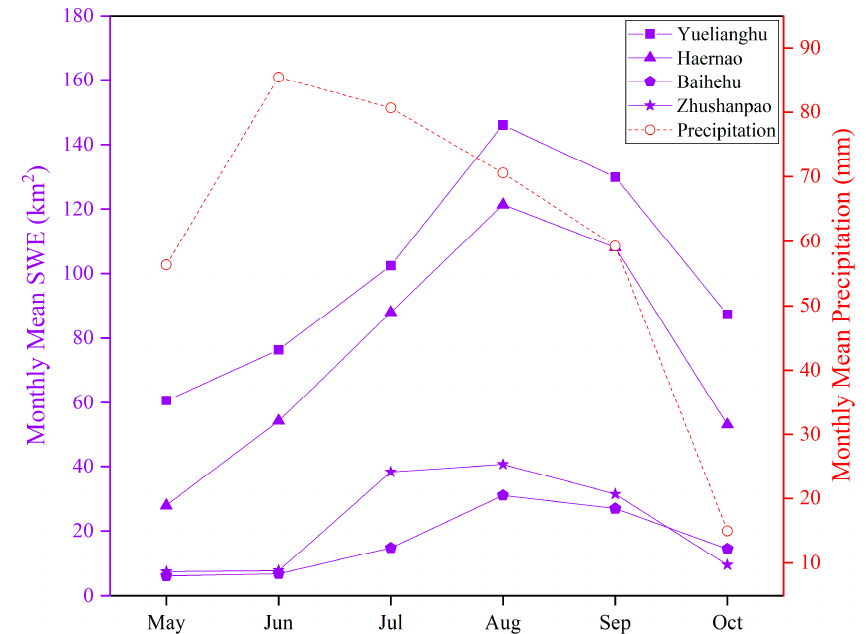
Figure 18. The relationship between monthly mean surface water extent (SWE) of four major water bodies and mean monthly precipitation in the Momoge National Nature Reserve, China from 2015 to 2019.